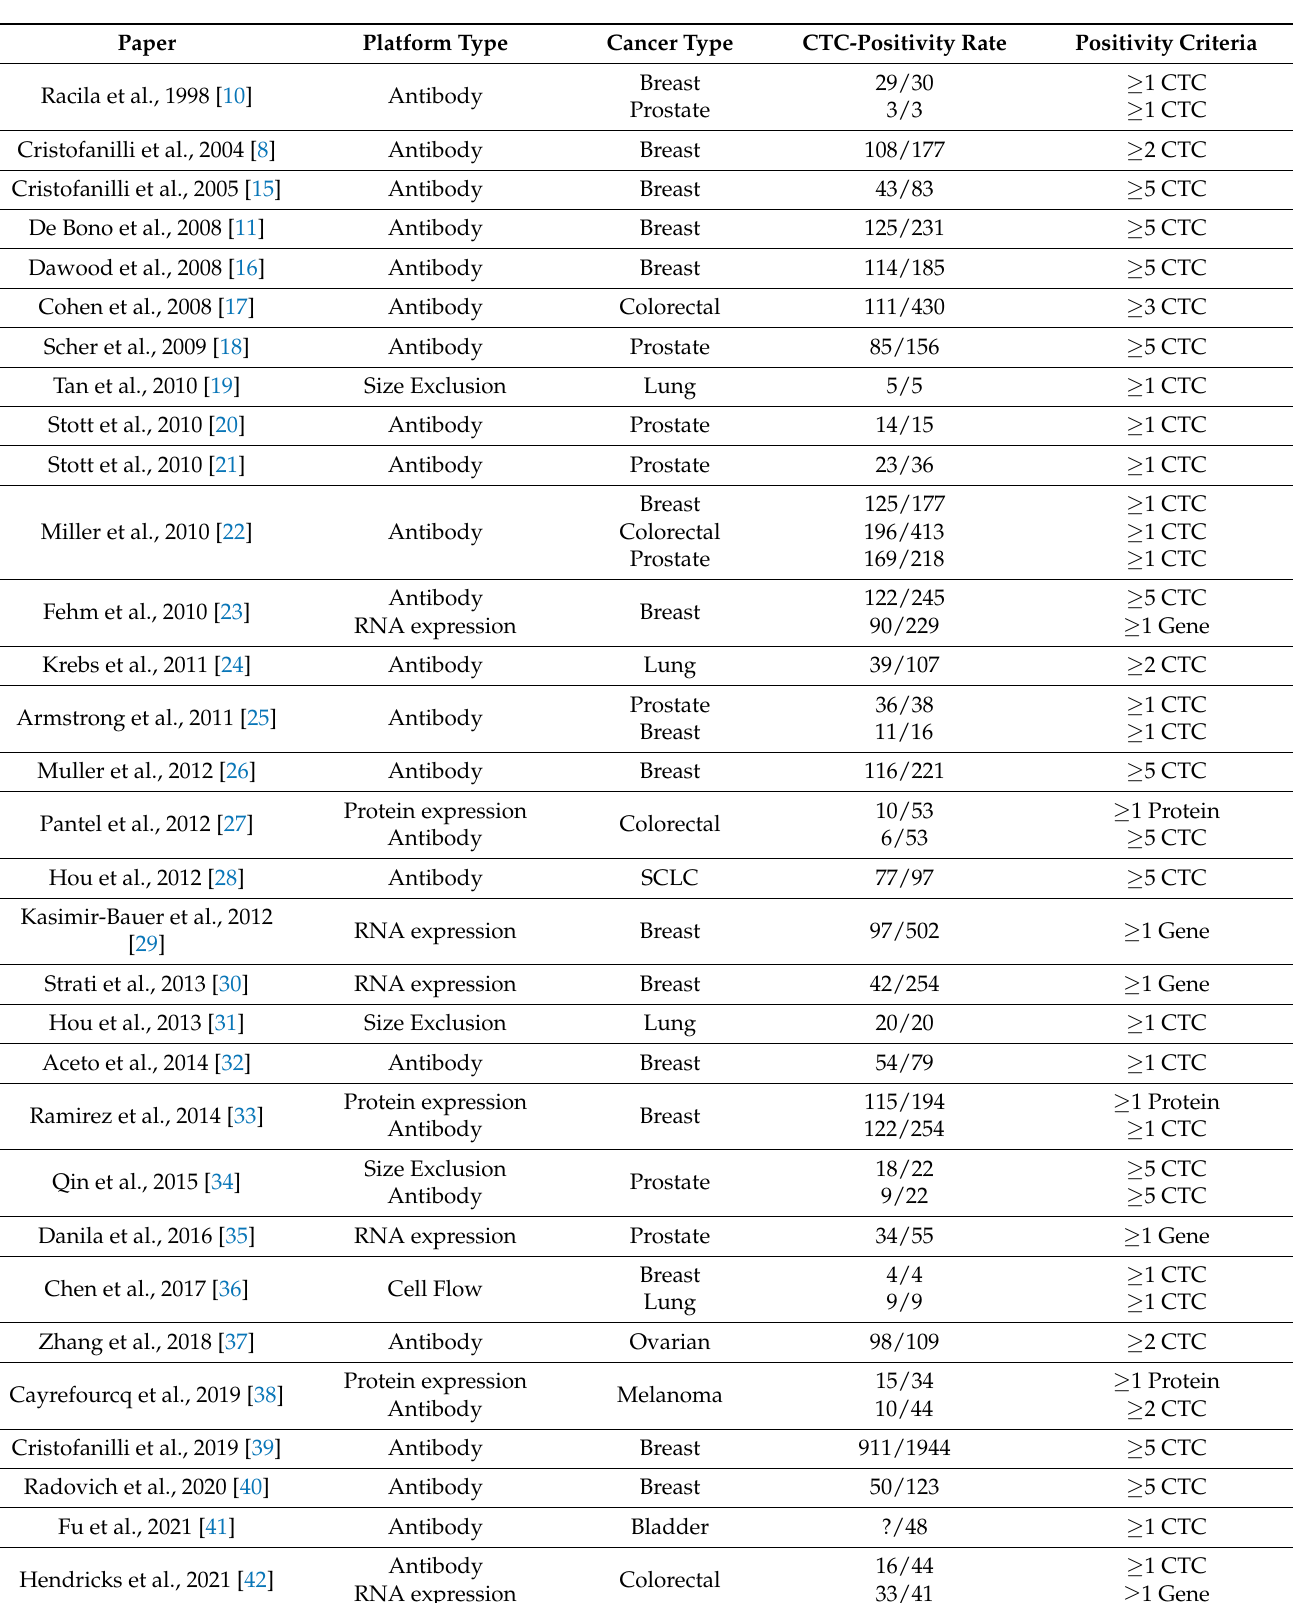
Table 1. CTC enumeration